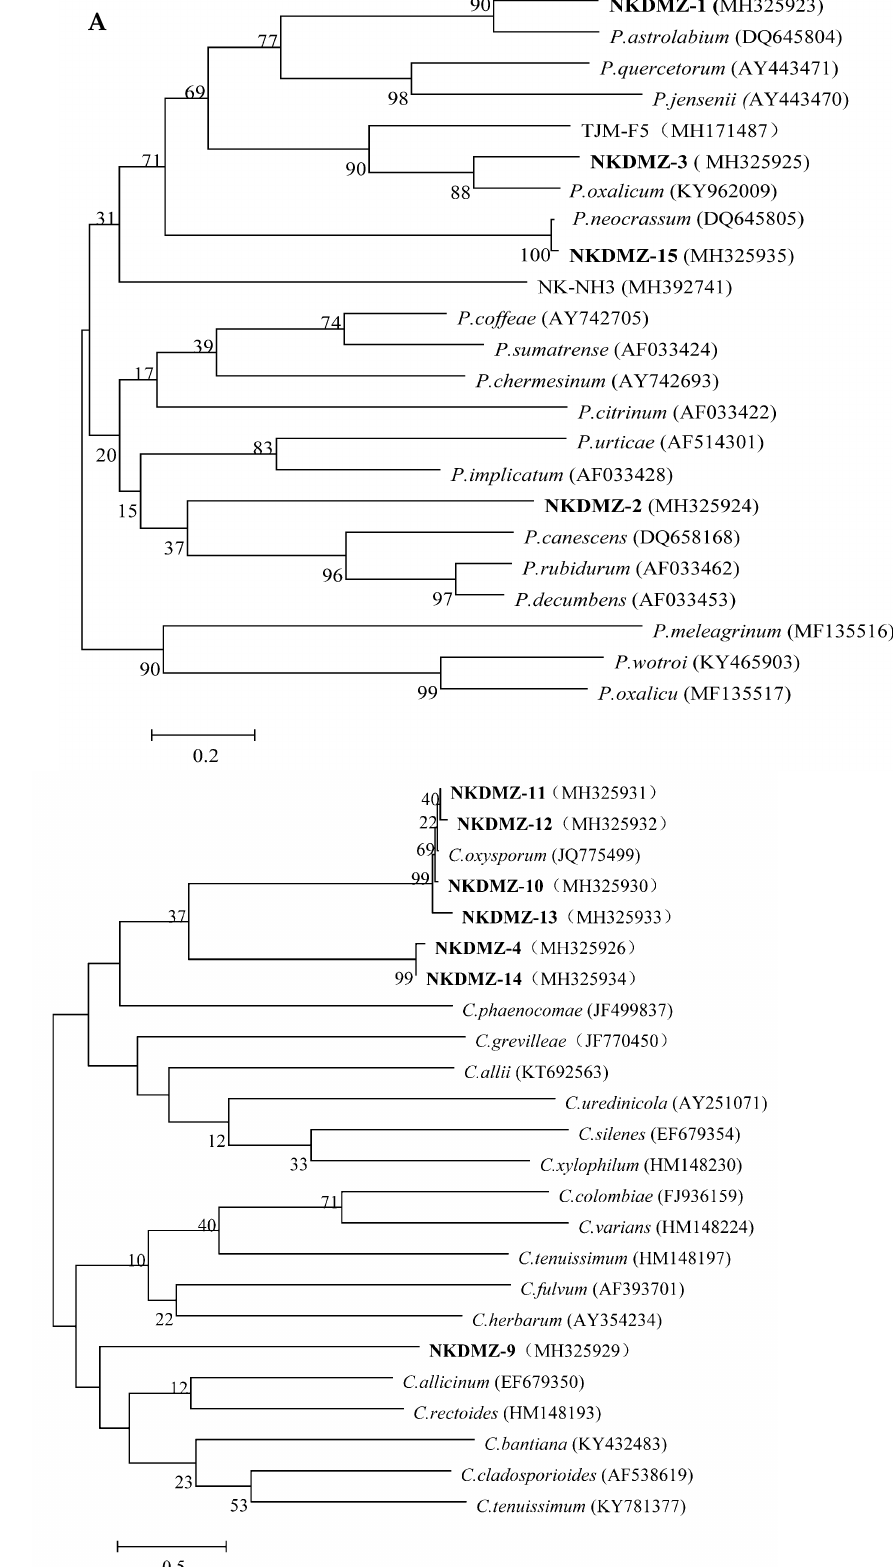
Figure 3. Neighbor-joining phylogenetic tree of Penicillium sp. ( A ) and Cladosporium sp. ( B ). Each of the ITS gene sequences used was 520–540 bp. The phylogenetic tree was constructed using the neighbor-joining method with 1000 bootstrap replicates. The scale bar indicates the expected number of substitutions/sites.